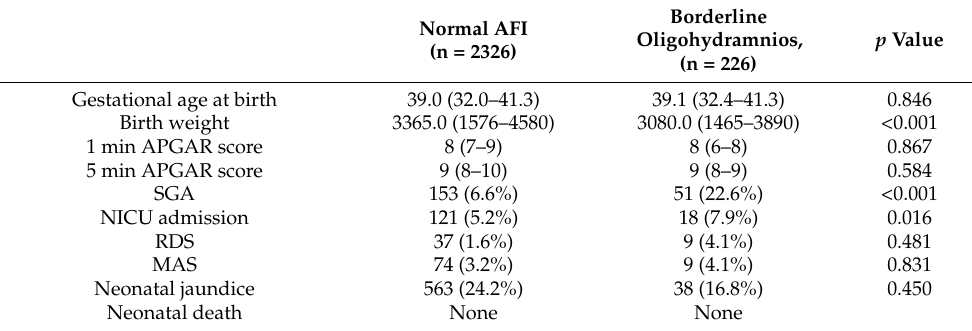
Table 5. Comparison of neonatal outcomes between normal AFI and borderline oligohydramnios in the 3rd